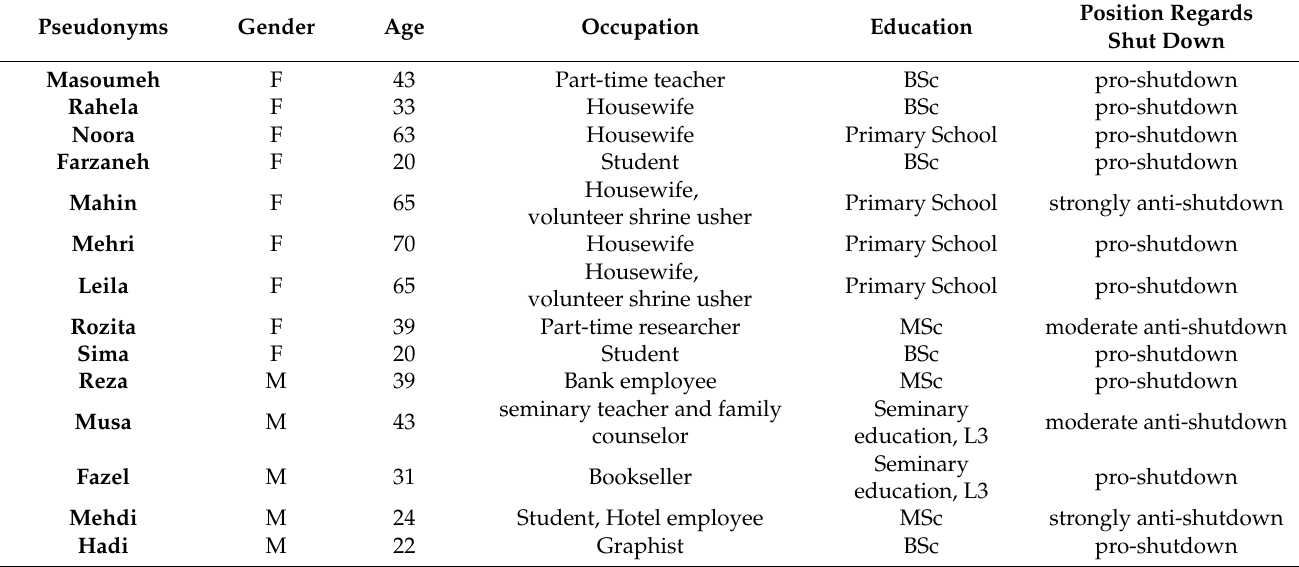
Table 1. Participants’ Demographic